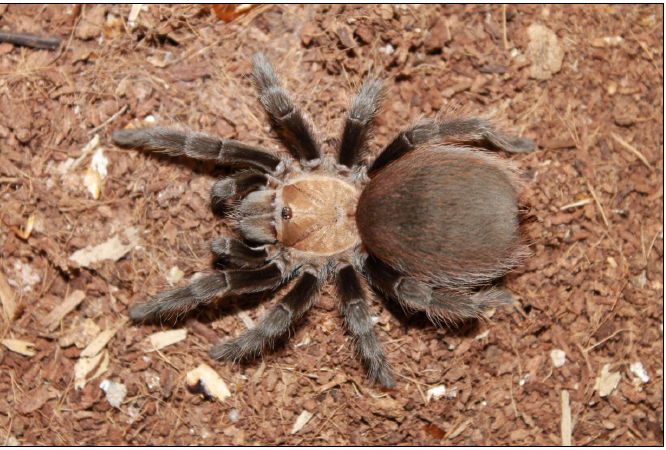
Figure 1. The Captive Bred Aphonopelma sp. Spider Used to Assess the Variables of the Study. (Photograph by Ron Wagler).